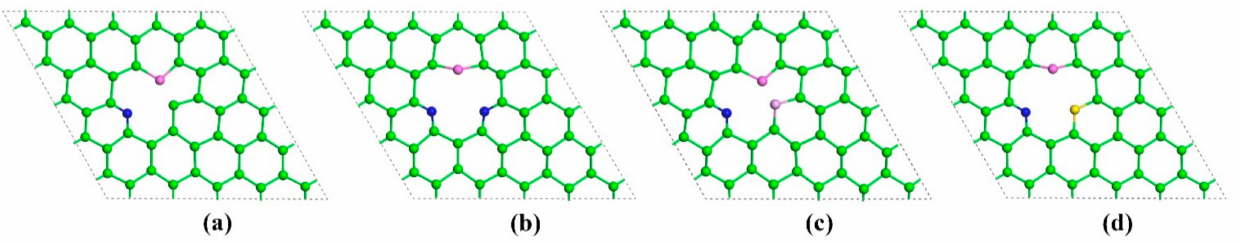
Figure 7. The atomic structures of proposed germanene-based models including single-vacancy